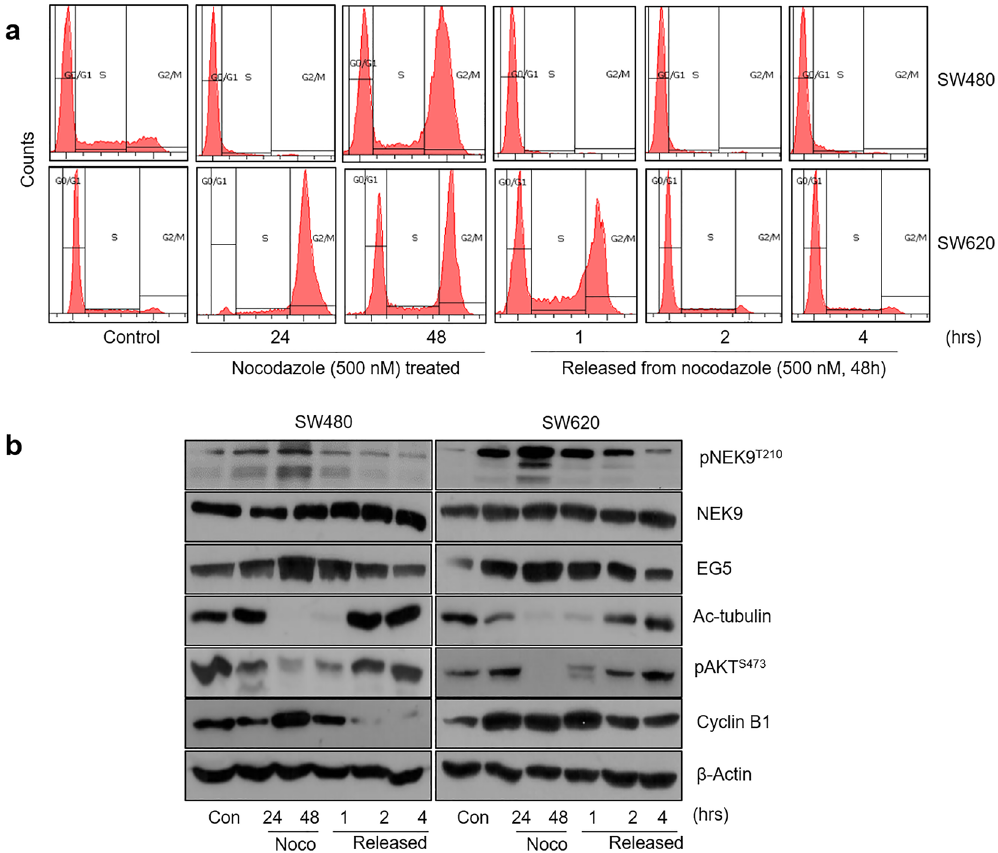
Figure 3. Concordant expression of the NEK9–G5 axis during the G 2 /M phase of the cell cycle. ( a ) Cell cycle distribution of SW480 and SW620 colon cancer cells treated with nocodazole (500 nM) for 24 or 48 h and then released from this block. ( b ) Western blot analysis of phosphorylated NKE9 (pNEK9 T210 ), NEK9, EG5, acetyl- tubulin, phosphorylated AKT (pAKT S473 ) and cyclin B1 at the indicated times of nocodazole–induced G 2 /M arrest, and after the release from this